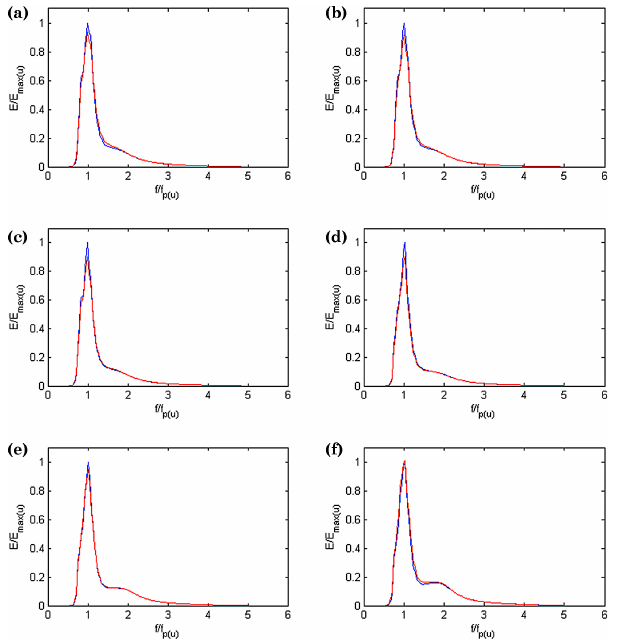
Figure 22. Modelled 1-D spectrum in the Aberdeen wave gauge, the red line is the coupled model (with WCIs incorporated), while the blue line is the uncoupled model: (a) 31 March 2010 at 00:30, (b) 31 March 2010 at 01:15, (c) 31 March 2010 at 02:00, (d) 31 March 2010 at 04:15, (e) 31 March 2010 at 06:00, and (f) 31 March 2010 at